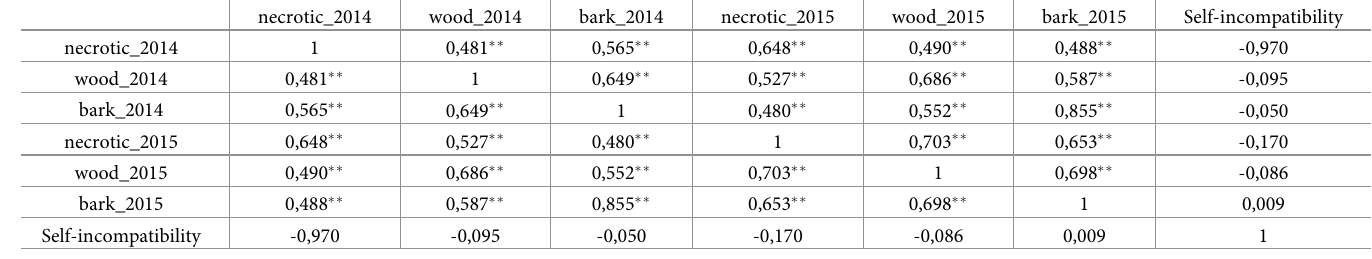
Table 1. Pearson correlation coefficients of the phenotypic parameters necrotic line, wood and bark discontinuity in the 92 seedlings of ‘Moniqui’ X ‘Paviot’ (MXP) F1 apricot progeny grafted on ‘Marianna 2624’ one year after grafting during the years 2014 and 2015.